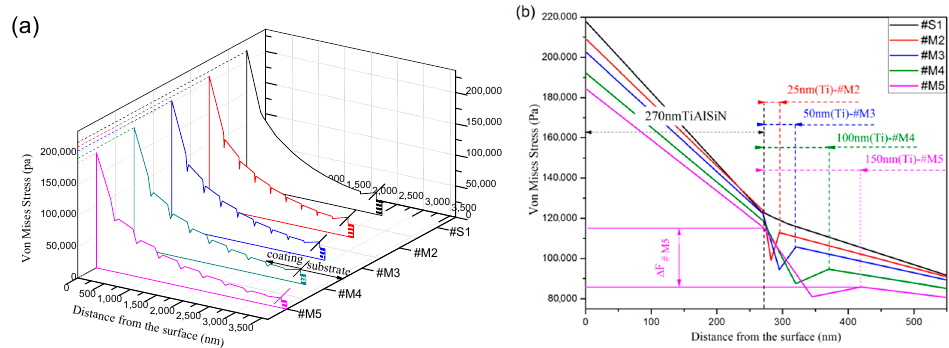
Figure 10. ( a ) Von Mises stress distribution along the symmetric axis from the top surface to the substrate, ( b ) the Von Mises stress in the depth range of 0 to 100 µ m. ∆ F is the Von Mises stress di ff erence between the upper and lower interfaces of Ti